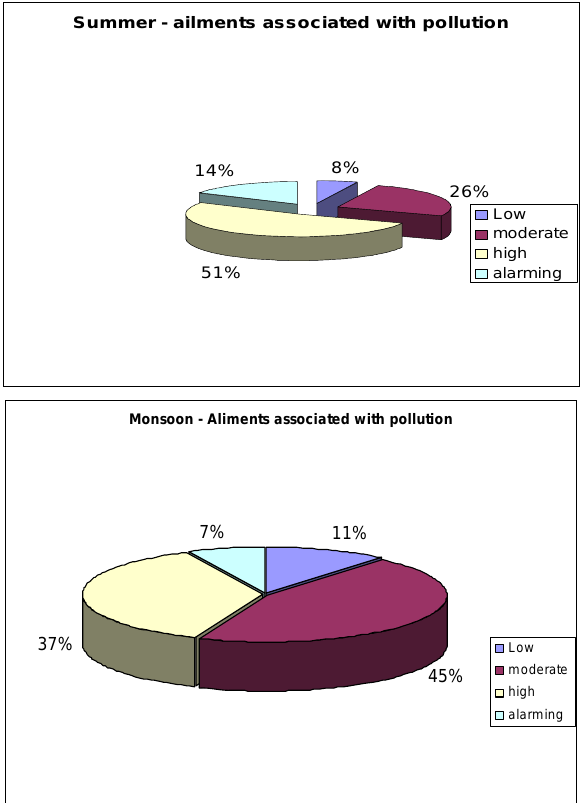
Figure 16: Summer and winter ailments associated with pollution in the study